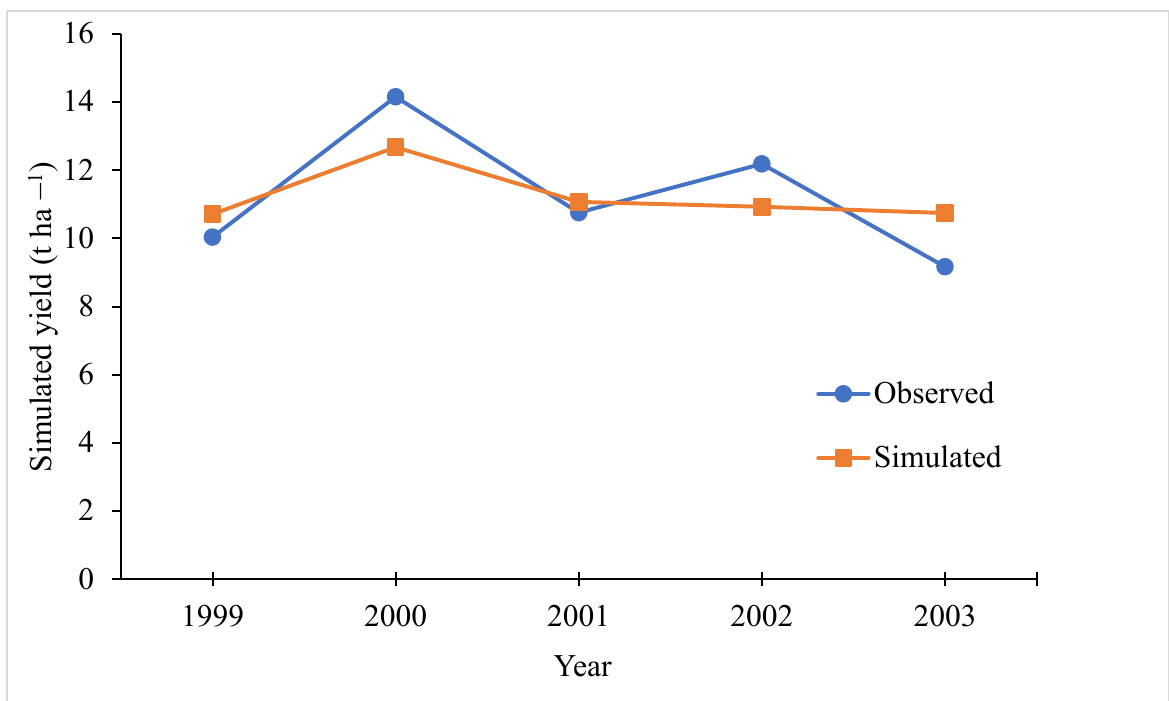
Figure A1. Showing the crop yields (observed and simulated) since the model was in the range set for acceptable model calibration for the study period after PHU calibration (figure obtained from [32]).